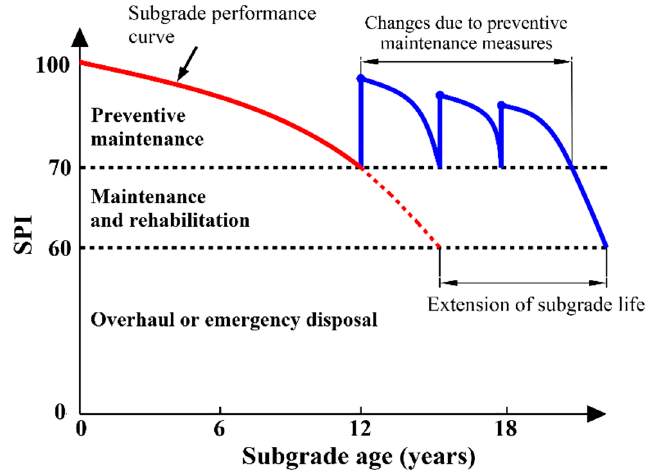
Figure 9. Subgrade performance curve of the life-cycle and an optimal time for preventive maintenance.